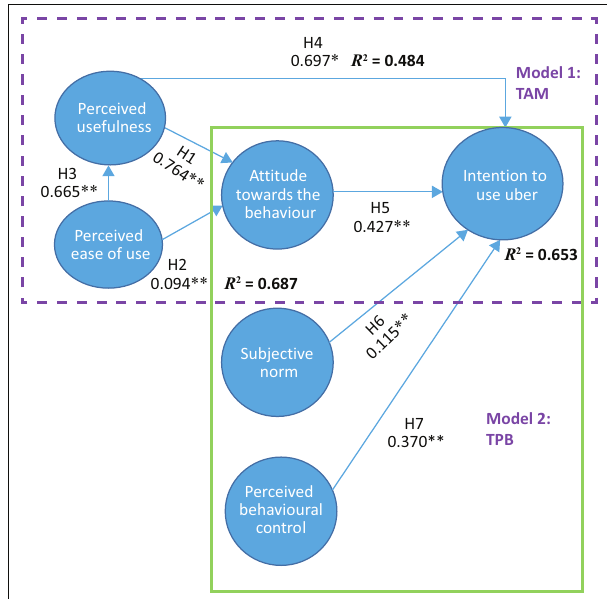
FIGURE 2: Model results.